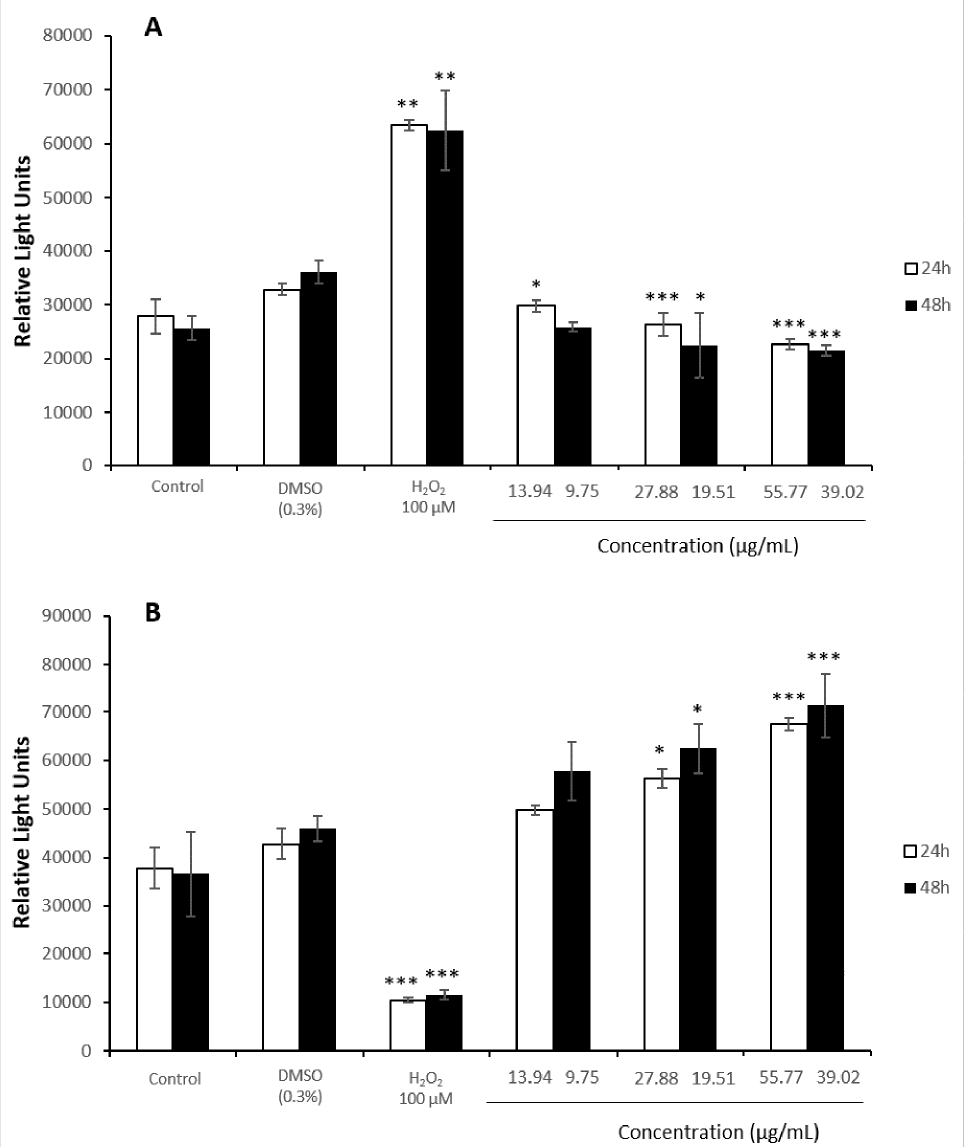
Figure 6. ROS content ( A ) and GSH content ( B ) in Caco-2 cells exposed to 0–55.77 μ g/mL or 0–39.02 μ g/mL stilbene extract (45%) during 24 h or 48 h, respectively. All values are expressed as mean ± SD. Differences were considered significant compared to the control group from p < 0.05 (*), p < 0.01 (**) and p < 0.001